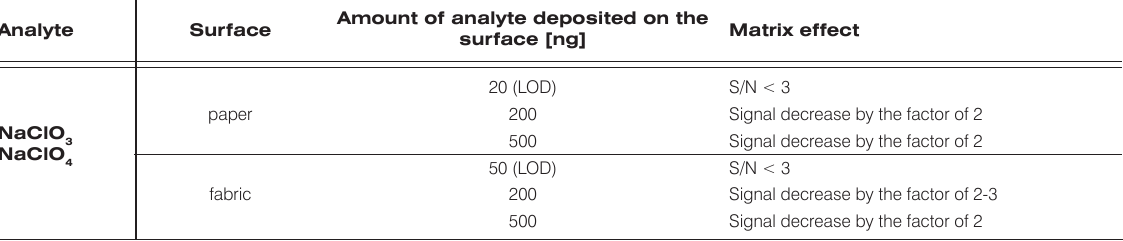
Amount of analyte deposited on the surface [ng] Matrix